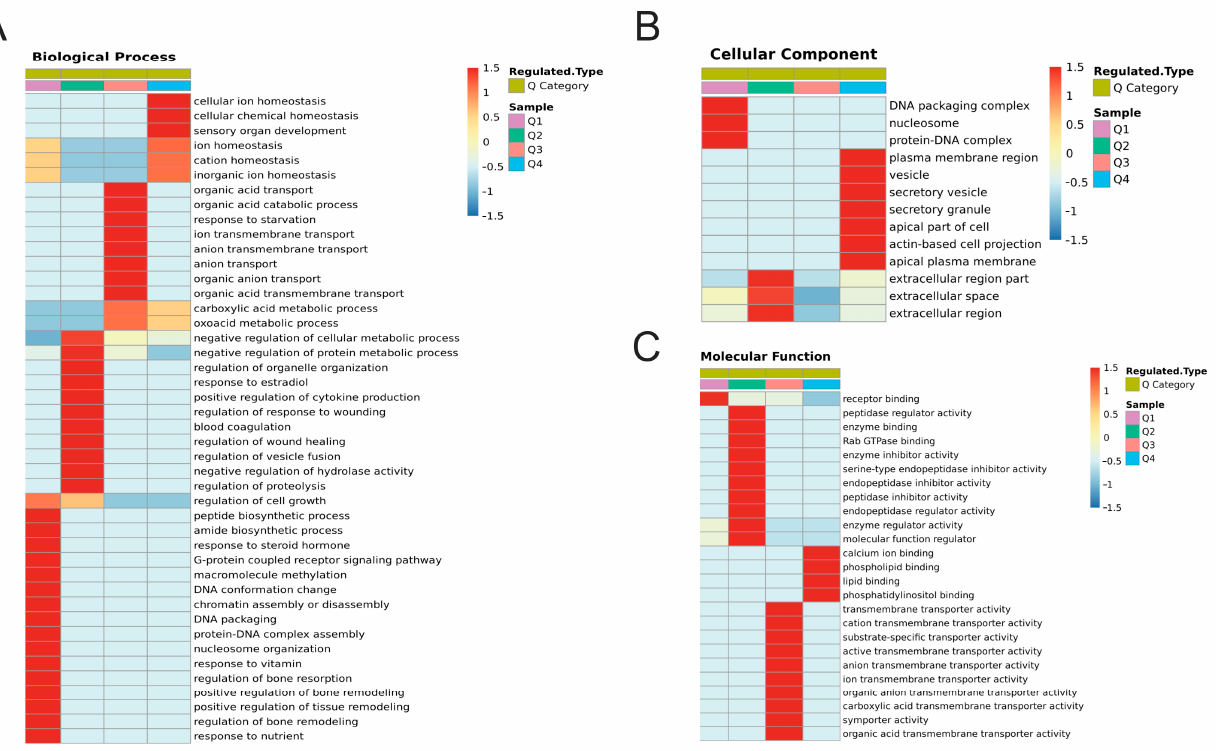
Figure 7. Cluster Analysis of DEPs based on GO classification. ( A ) Heat map for cluster analysis of DEPs based on the biological process module of GO classification. ( B ) Heat map for cluster analysis of DEPs based on the cellular component module of GO classification. ( C ) Heat map for cluster analysis of DEPs based on the molecular function module of GO classification.